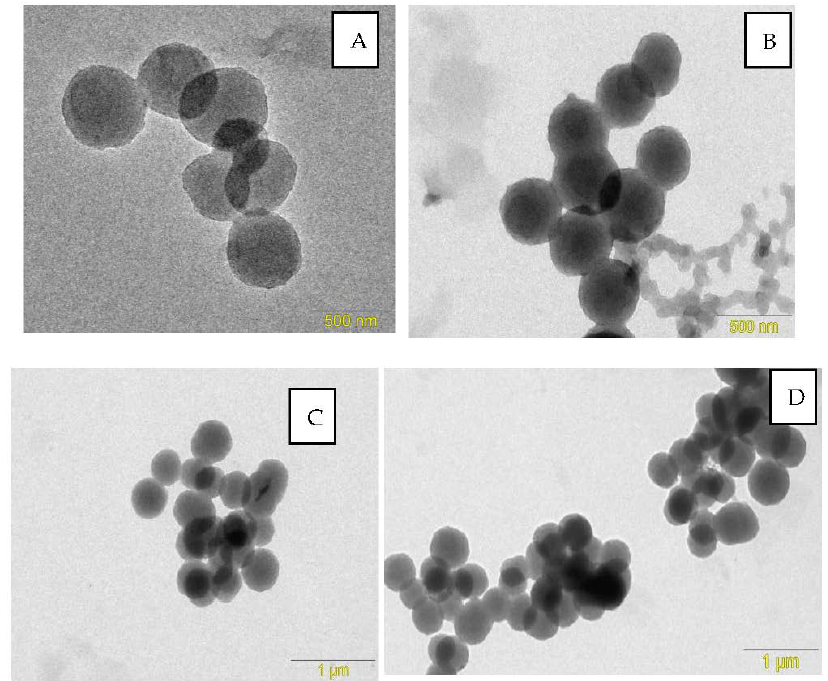
Figure 3. TEM micrograph of the modified magnetite nanoparticles, ( A , C ) MMIPs, and ( B , D ) MNIPs.